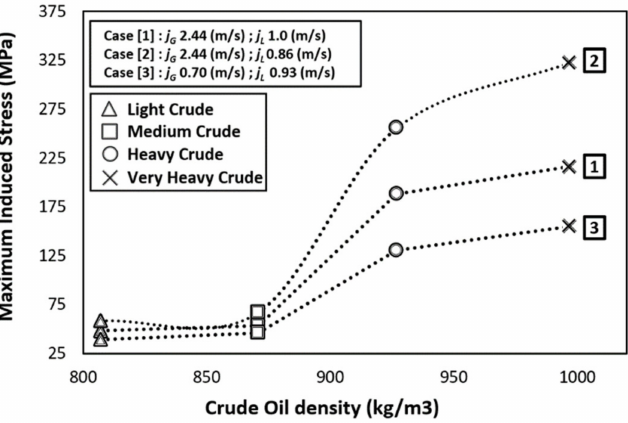
Figure 15. Effect of varying crude oil grades on maximum induced